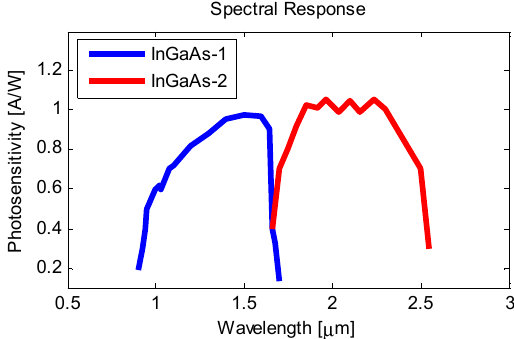
Figure 1. Spectral response of each of the cells that comprise the photodiode. Temperature gradients measured in a static point located in the workpiece of a grinding operation can reach an order of magnitude of 4000 °C/s. To capture and outline such temperature changes, a rapid response sensor is essential. The sensors’ maximum 10 to 90 rise time is 200 ns.